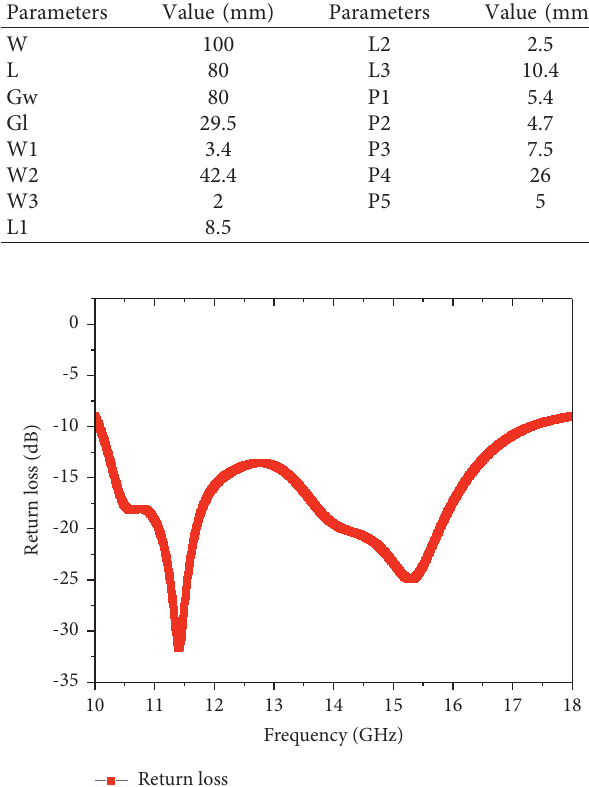
Figure 3: The return loss response of the single MD antenna.